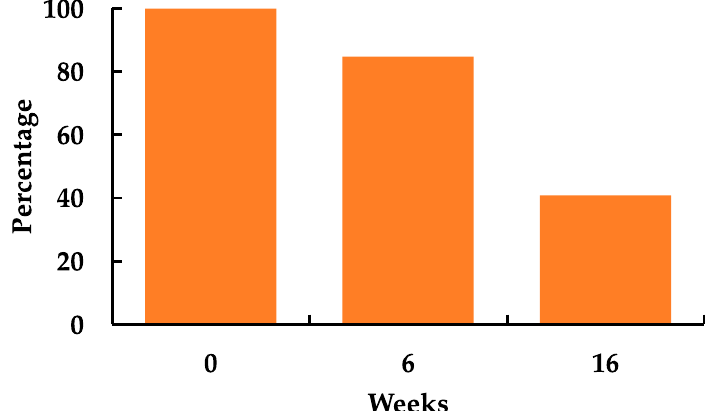
Figure 5. Deterioration of starch solution after four weeks and four months. Each sample was run at 50 μ g/mL in the wavelength range of 250–800